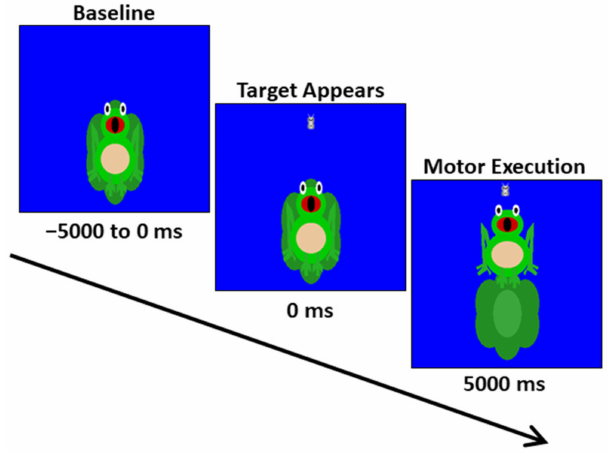
Figure 1. Depiction of the MEG Frog Task experimental paradigm. The trial length was 10,000 ms in total. The participants started each trial at rest for 5000 ms. Subsequently, a target moth would appear, prompting the participant to generate an isometric knee extension force that matched the force value. The target forces varied between 15 and 30% of the participant’s maximum isometric force and were available to be matched for up to 5000 ms. A successful match occurred when the moth that represented the target force was inside of the frog’s mouth for 300 ms. The participants completed 120 target matching